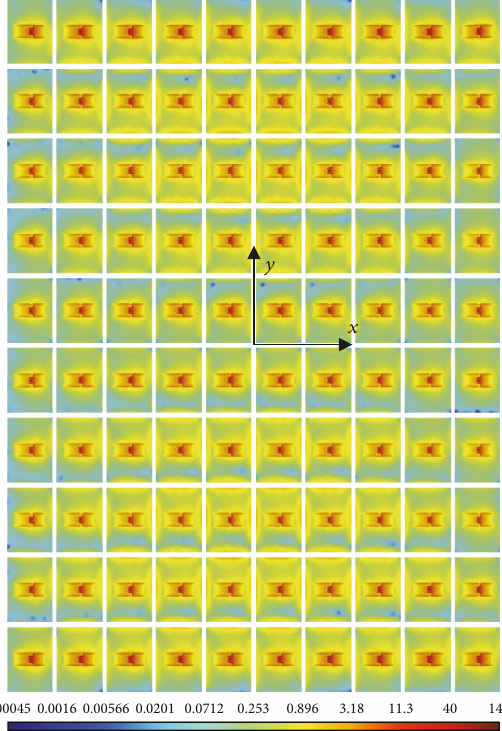
Figure 4: Current density distribution of 10 × 10 patch array.